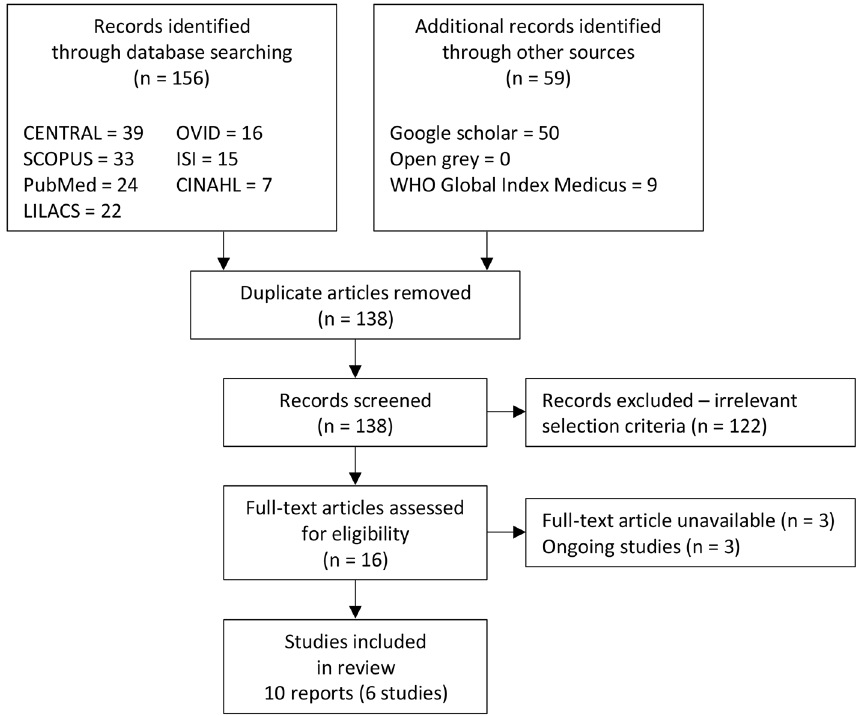
Figure 1. PRISMA